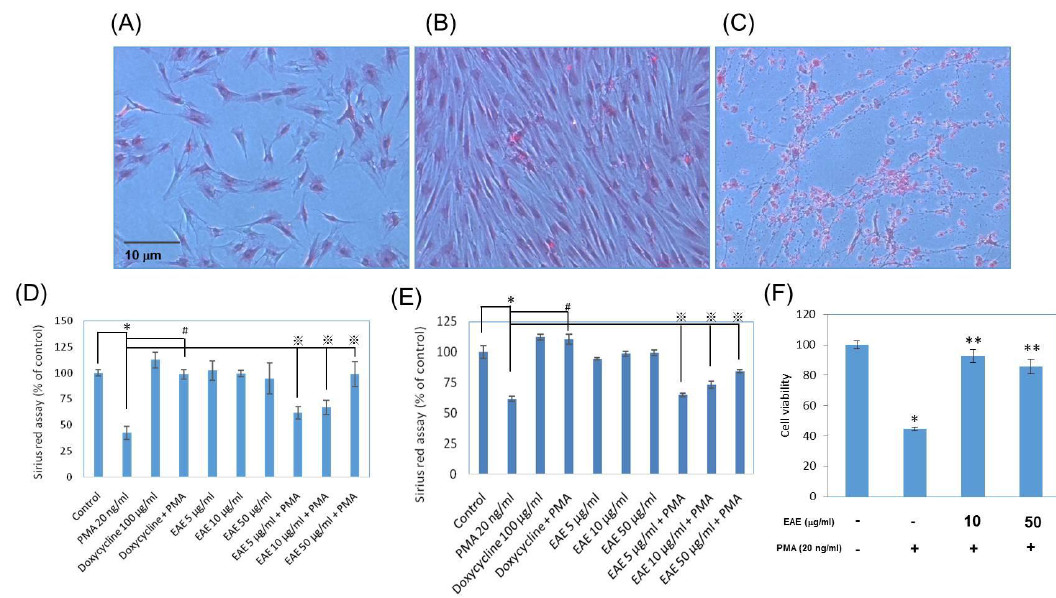
Figure 4. Human normal epidermal fibroblasts collagen production with EAE treatments in sirius red assay. In ( A ) Day 1, at 50 μ g/mL; ( B ) Day 7, at 50 μ g/mL; and ( C ) PMA, at 20 ng/mL treated 24 h. Sirius emitted bright red color (microscopy, the magnification is 100×); ( D ) Day 1 and ( E ) Day 7 have been quantitative; ( F ) Anti-oxidative effect of EAE in PMA-activated fibroblast viability. (Data represents mean ± S.D. of three independent experiments performed. * p < 0.01, # p < 0.01 and ※ p < 0.01).